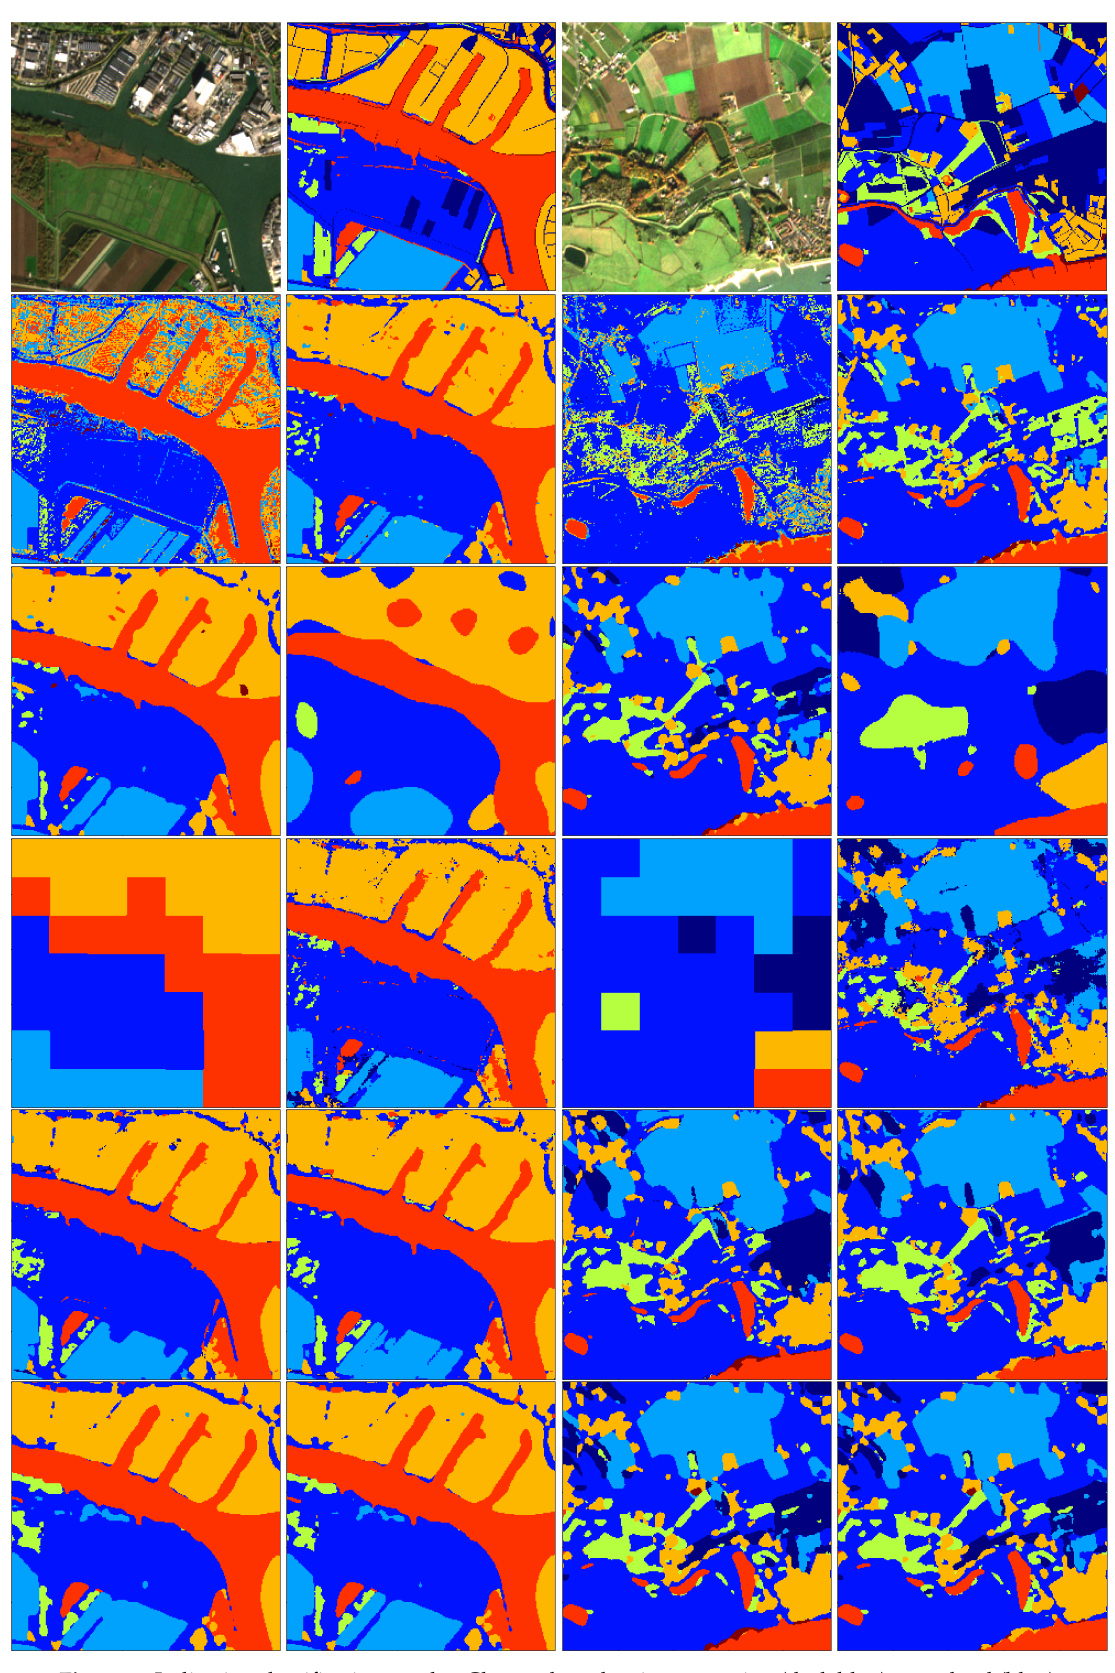
Figure 7. Indicative classification results. Classes: low-density vegetation (dark blue), grassland (blue), cropland (light blue), built-up (blue-green), forest (green), other (orange), water (red), and remaining classes